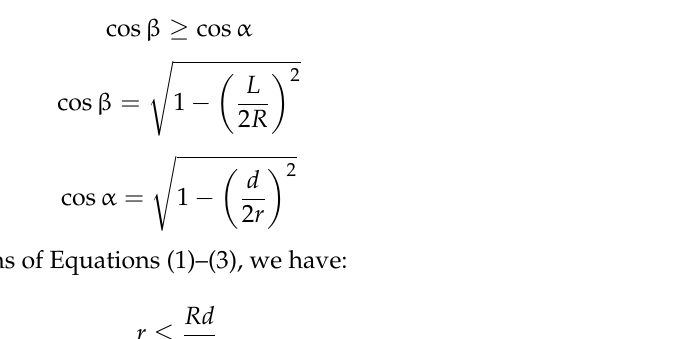
Figure 3. Schematic diagram of formed surface and basic unit’s ball head: ( a ) formed part surface; ( b ) basic unit.